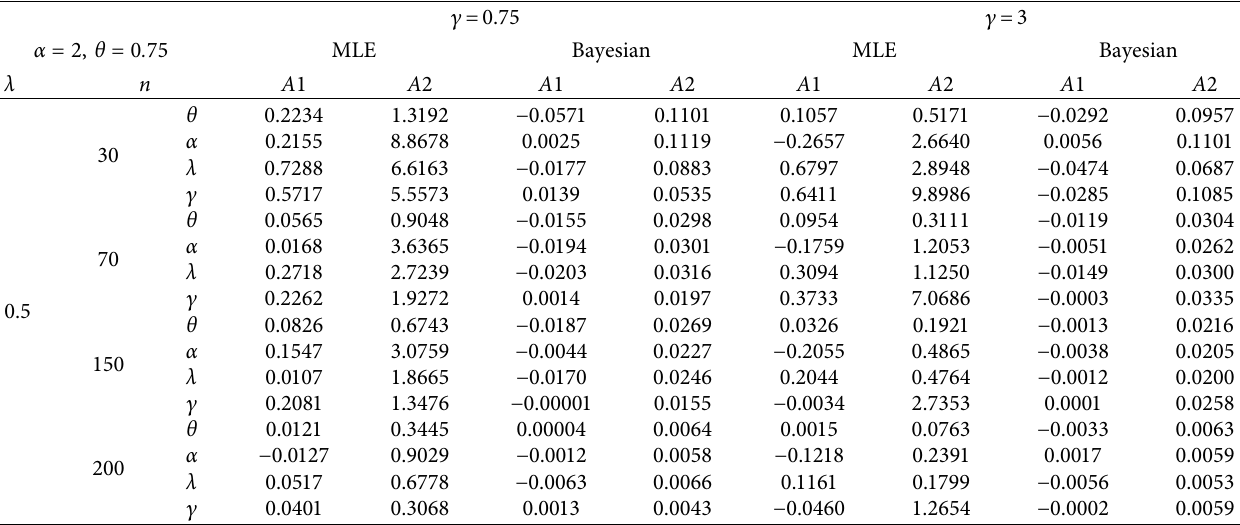
Table 2: A 1, and A 2 of MOEGM parameters by MLE, and Bayesian when. α � 2 , λ � 0 .